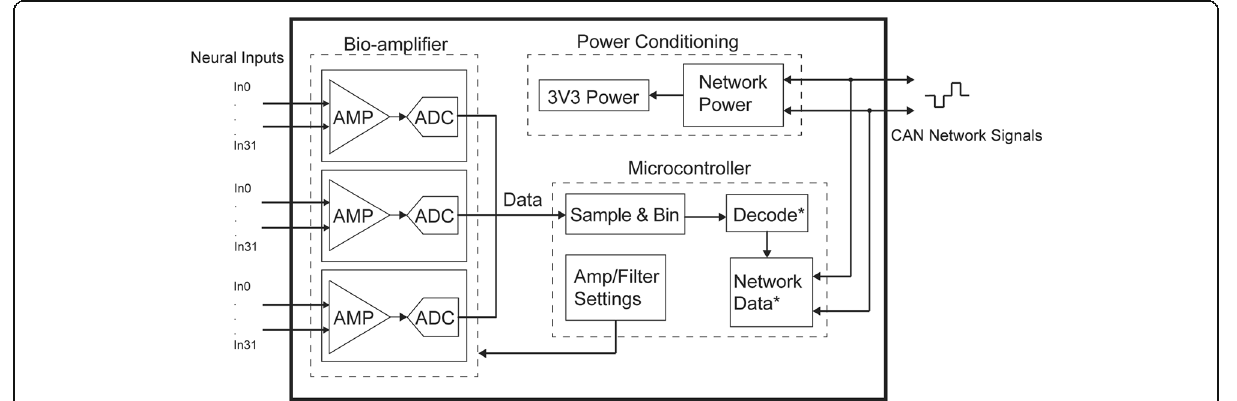
Fig. 2 Block diagram of the neural recording module. (*) indicates future work not presented